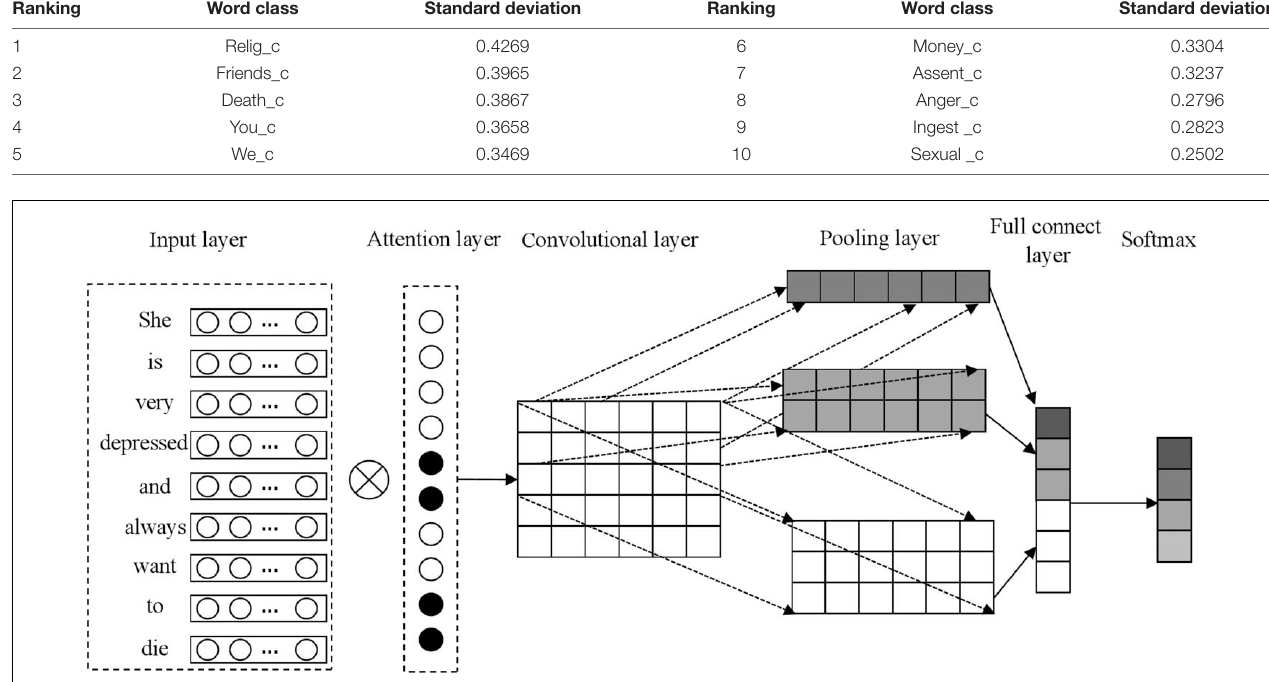
FIGURE 2 | The linguistic inquiry and word count (LIWC)-CNN model